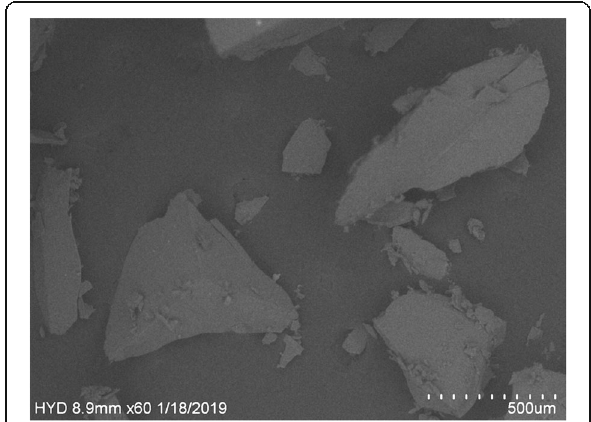
Fig. 3 SEM image of 0.218 g/ml of solute in acetone obtained by solvent evaporation method carried out for 24 h with 100 rpm stir (× 60)